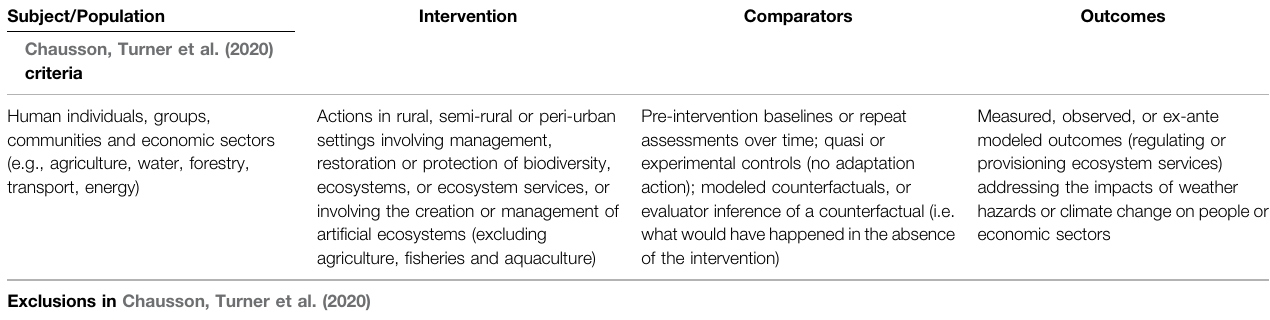
TABLE 2 | Framing of the search criteria for the systematic review: differences to the global review by Chausson, Turner et al. (2020).